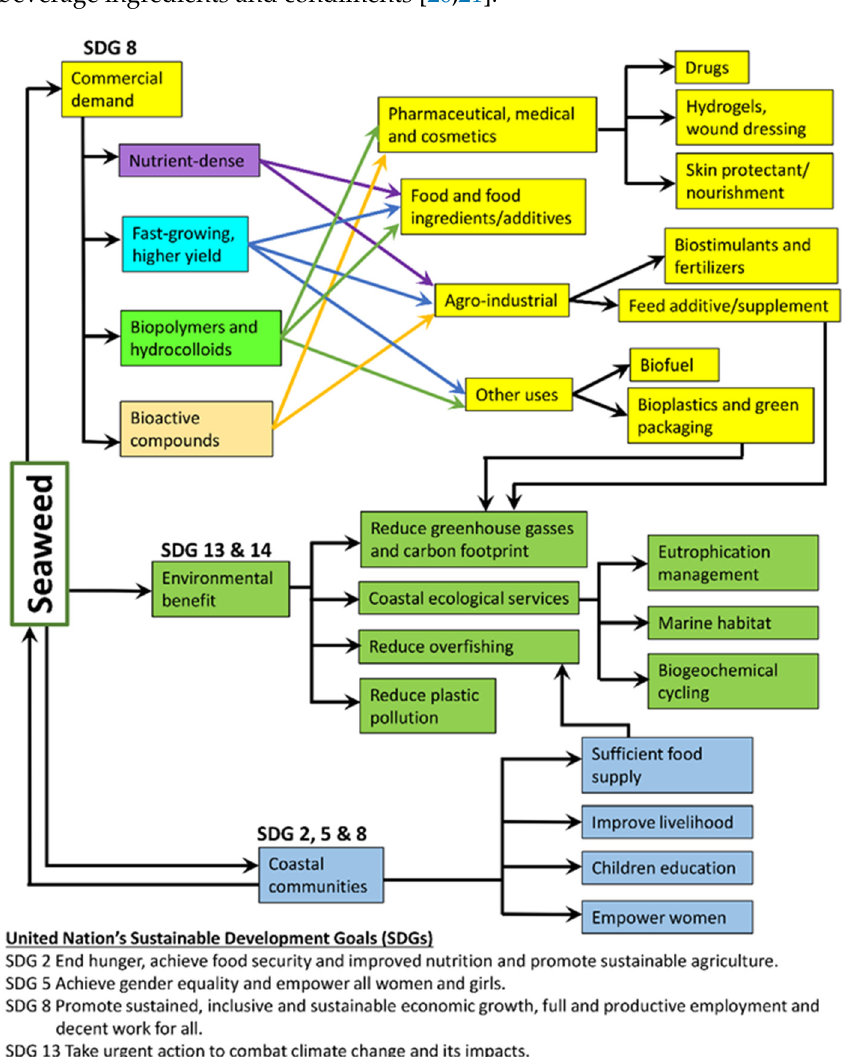
Figure 1. The intricate web of the relationships between commercially demanded seaweed attributes and their potential contributions to the United Nation’s Sustainable Development Goals (SDGs).